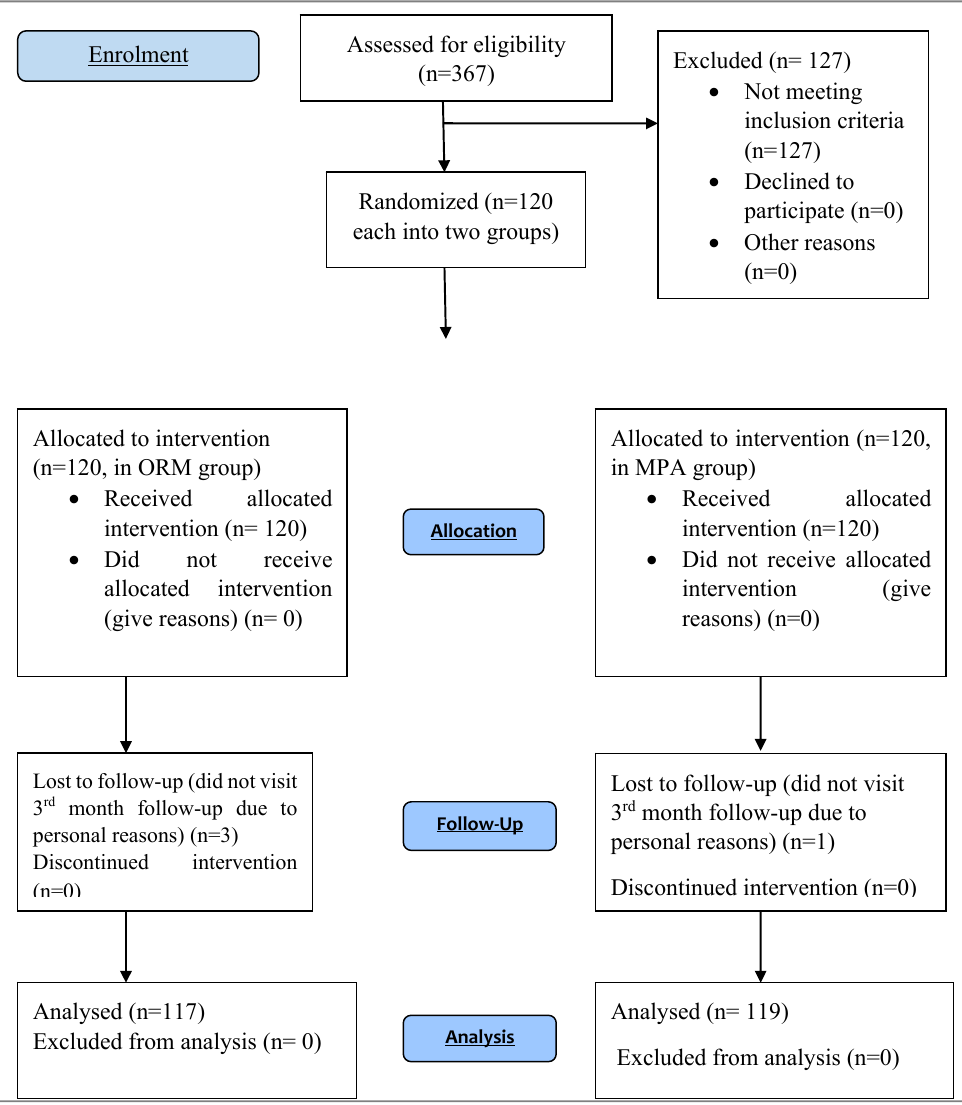
Figure 1. CONSORT diagram of the study.